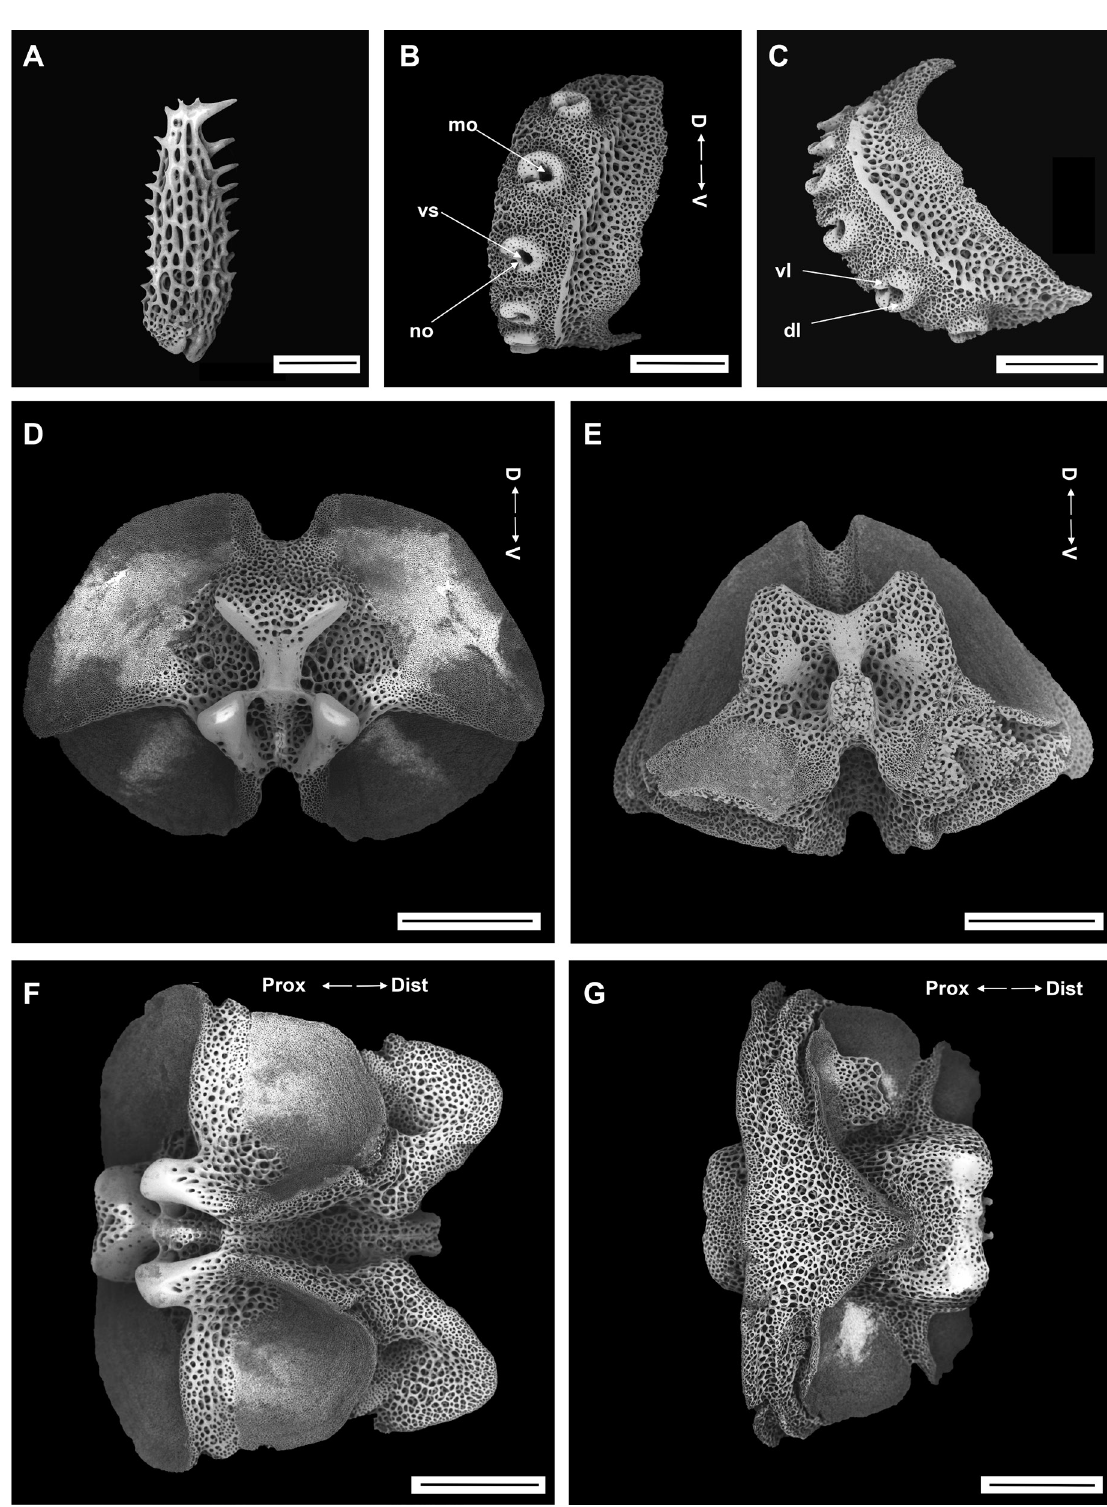
Fig. 22. Ophientrema scolopendrica (Lyman, 1883), SEM (IDSSE EEB-SW0020). A . Ventral arm spine. B–C . Lateral arm plate. D–G . Vertebrae. D . Proximal view. E . Distal view. F . Ventral view. G . Dorsal view. Abbreviations: D = dorsal; Dist = distal; dl = dorsal lobe; mo = muscle opening; no = nerve opening; Prox = proximal; V = ventral; vl = ventral lobe; vs = volute-shaped. Scale bars: A = 200 µm; B = 300 µm; C–G = 500